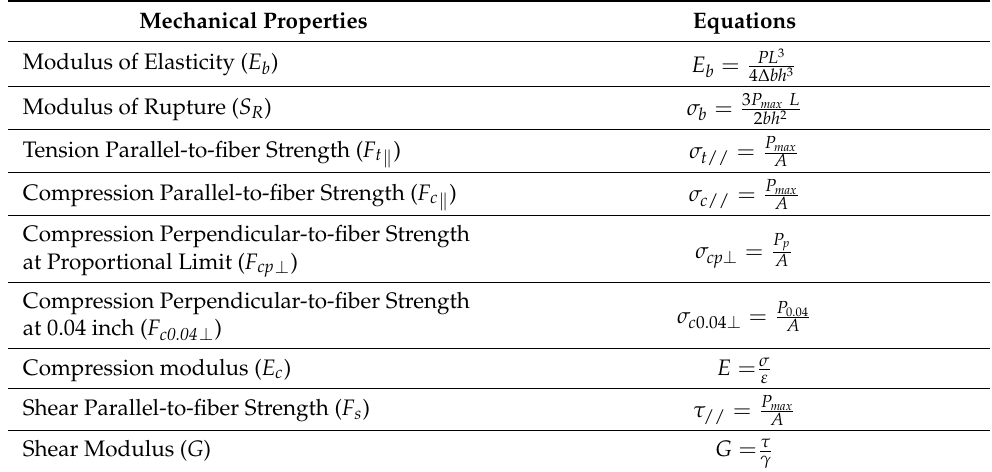
Table 2. Equations used to determine mechanical properties of timber and bamboo